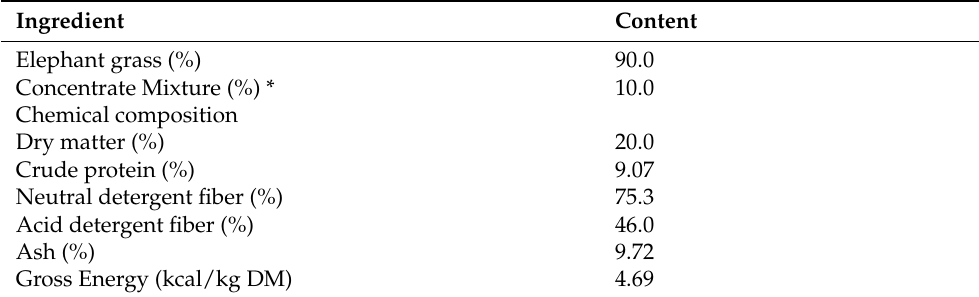
Table 1. Major ingredients and chemical composition of the experimental basal feed substrate based on dry matter